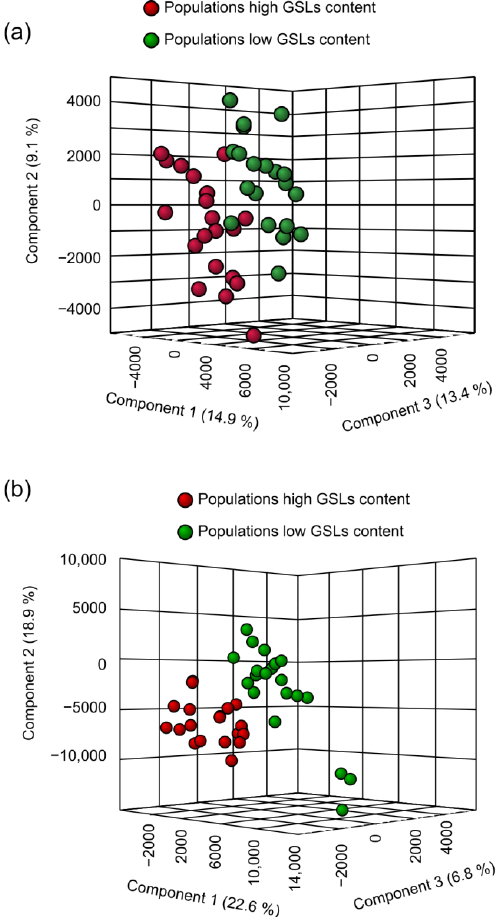
Figure 3. Untargeted metabolomics analysis on kale populations with high and low glucosinolates content evaluated at control (20 °C) and cold (12 °C) temperatures. ( a ) Score-plot of the three principal components from a PLSD analysis under control (20 ° control (20 °C)) conditions. Ten biological replicates were used per population. ( b ) Score-plot of the three principal components from a PLSD analysis under cold (12 °C) conditions. Ten biological replicates were used per population.